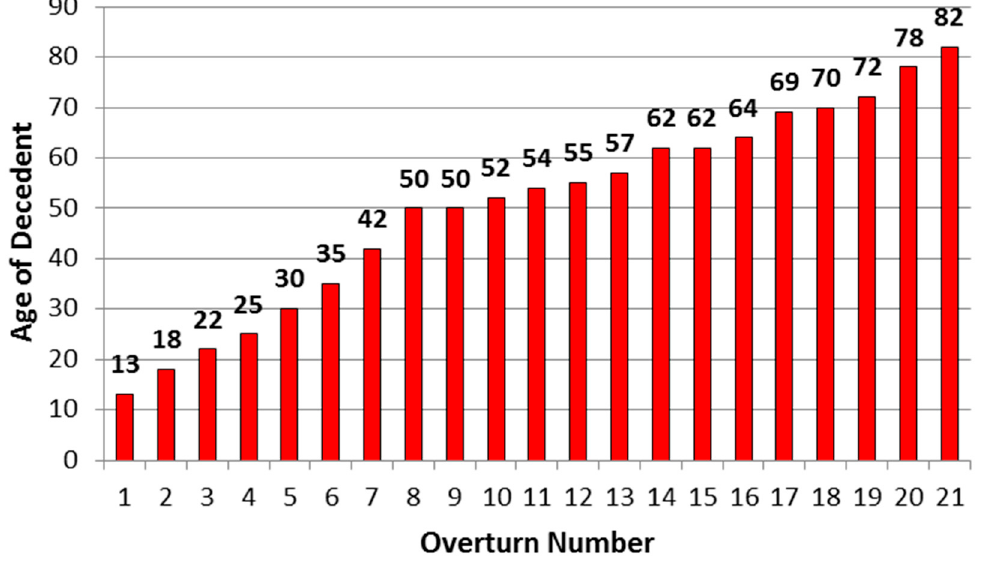
Figure 2. Age of operators killed in an overturn of non-ROPS tractors in Kentucky, 1960–2002, n = 21.